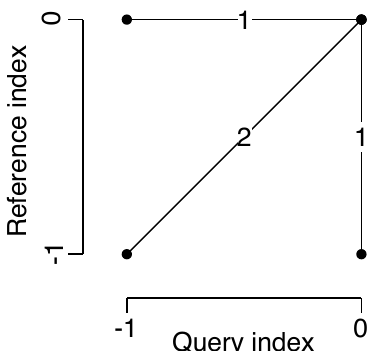
Figure 7. Symmetric2 step-pattern used in DTW